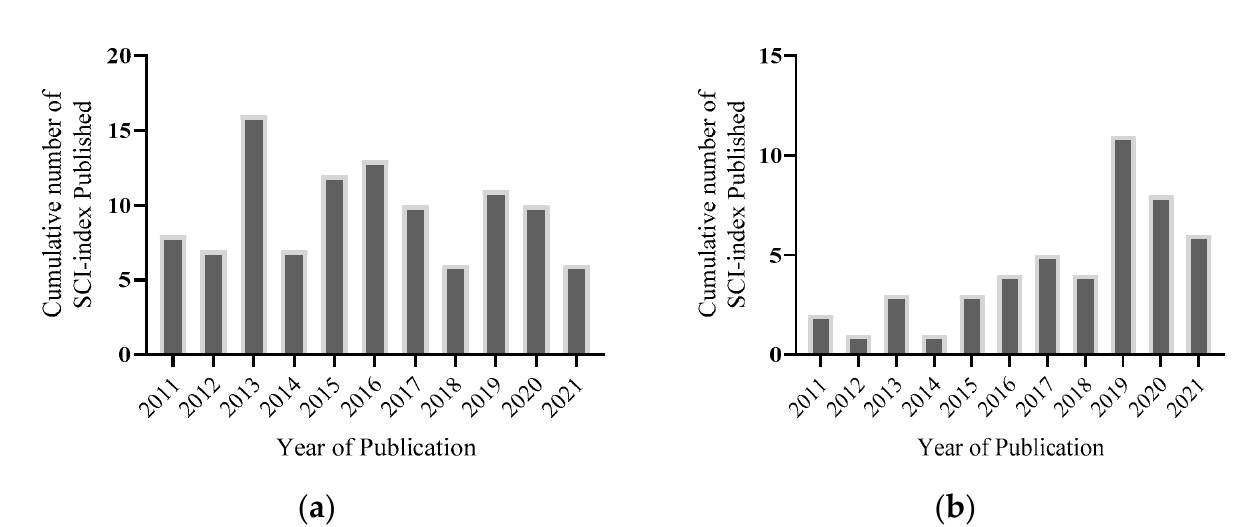
Figure 7. ( a ) Illustrated cumulation of SCI-indexed publications on Web of Science demonstrating research interest of EGCG in tissue engineering with the search terms of “antioxidants”, “skin wound”, “reactive oxygen species”, “epigallocatechin gallate”, “biomaterials”, “chronic wound healing”, “mechanism of actions”, and “tissue engineering”. ( b ) Graph signifies the publications referencing “EGCG” and “biomaterials” for skin wound healing over 10 years. Table 3. Current study of EGCG incorporated treatment for wound